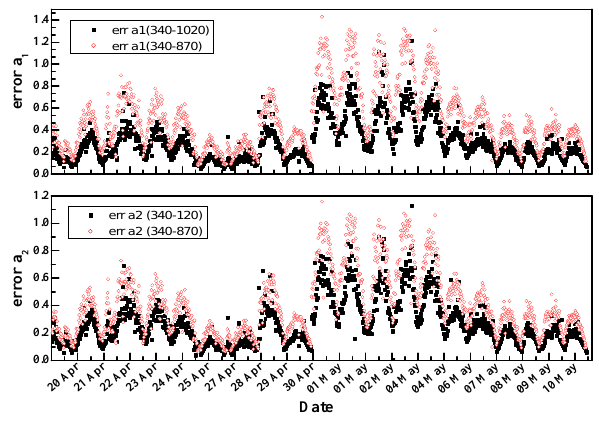
Fig. 4. Day-to-day variation of the errors in a 1 (top) and a 2 (bottom) in the spectral bands 340–1020nm and